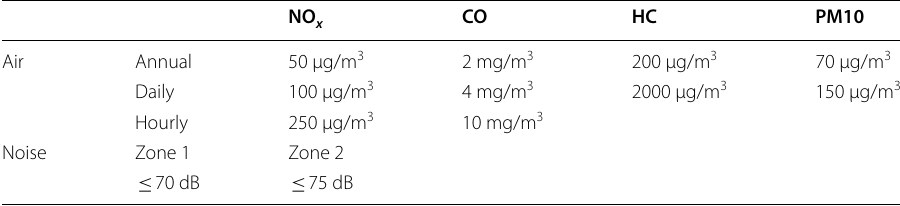
Table 3 Ambient air quality and noise